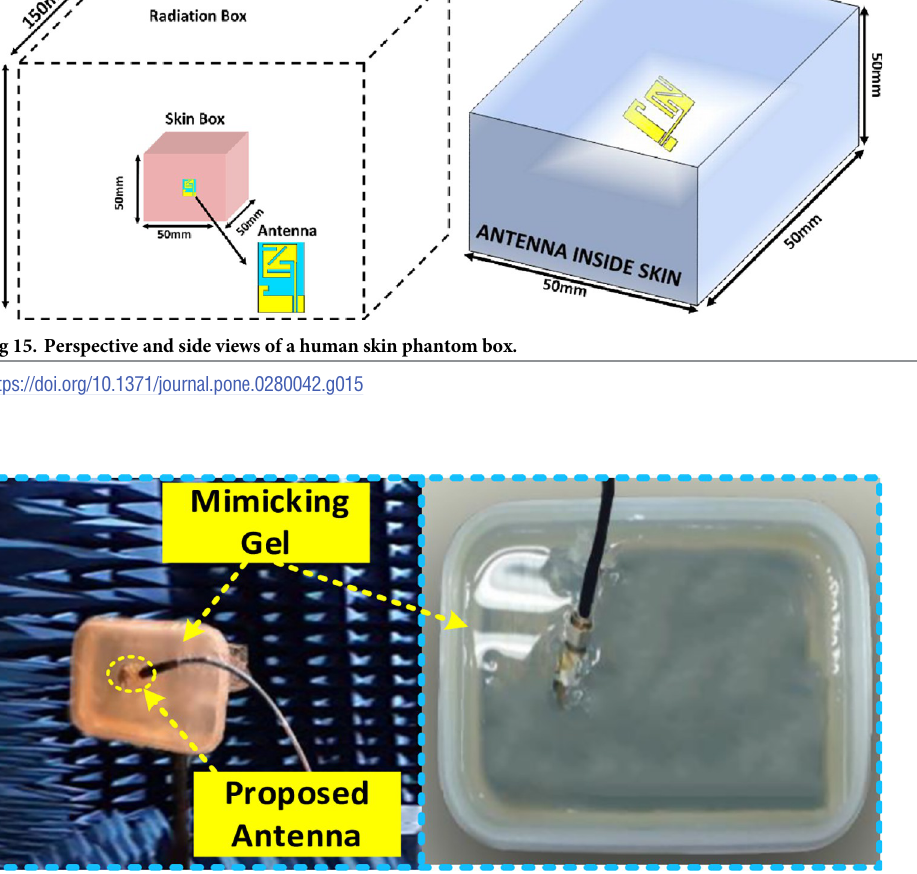
Fig 16. In human tissue’ skin-mimicking gel,’ antenna measurements are performed.